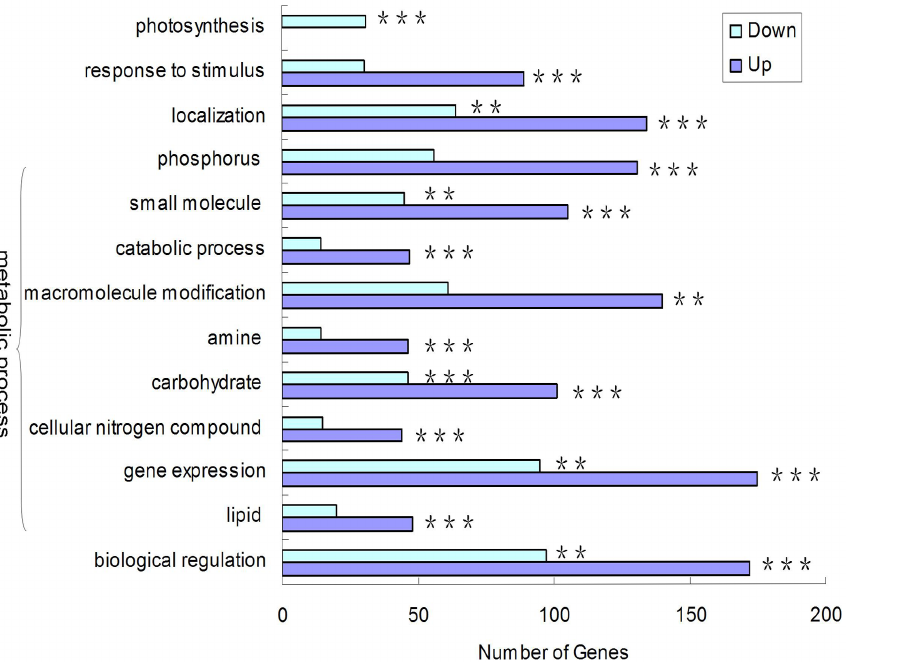
Figure 4. GO slim categories in up- and down-regulated RT genes combined from this experiment and three other reported studies. Bars show number of genes with significantly higher relative transcript abundance. All GO slim categories significantly over- or underrepresented are calculated based on a hypergeometric distribution. Significant over- or under-represented categories are indicated by * for p # 0.05, ** for p # 0.01, and *** for p # 0.001.